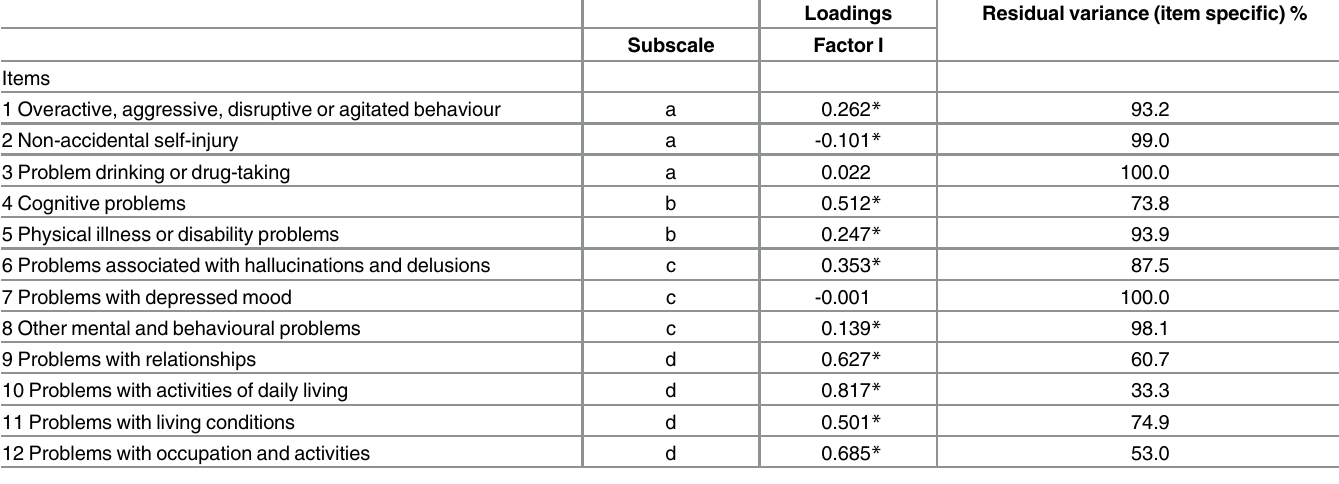
Table 1. Loadings for the one-factor Confirmatory Factor Analysis (N =